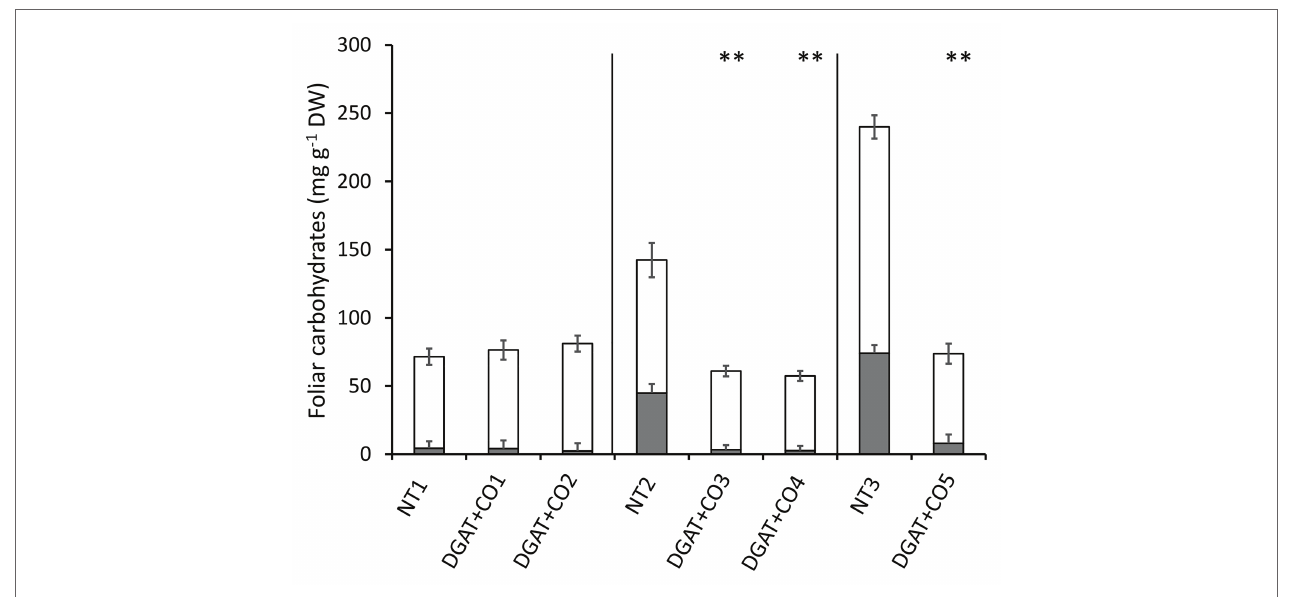
FIGURE 2 | Stacked means (±SE) of high molecular weight carbohydrates (shaded grey, ) and low molecular weight carbohydrates (shaded white, ) in the leaves of five DGAT + CO transformed L. perenne lines and respective non-transformed controls. Matching genetic backgrounds are grouped together. n = 10. ** Statistically differs from NT, p <